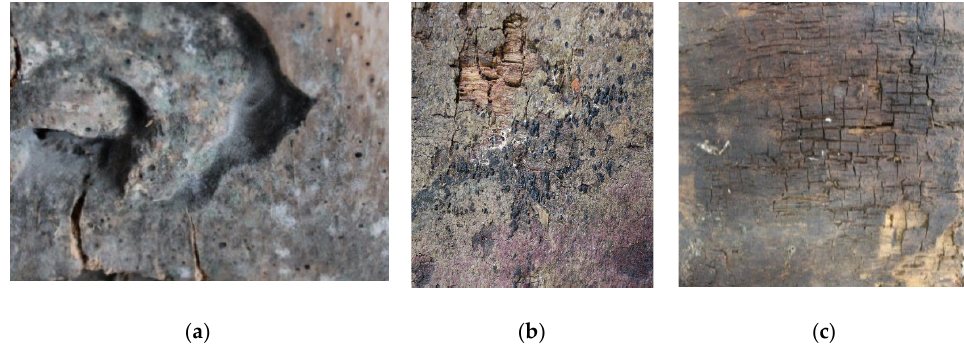
Figure 2. Degradation of wood support: mold ( a ) and rot ( b , c ).